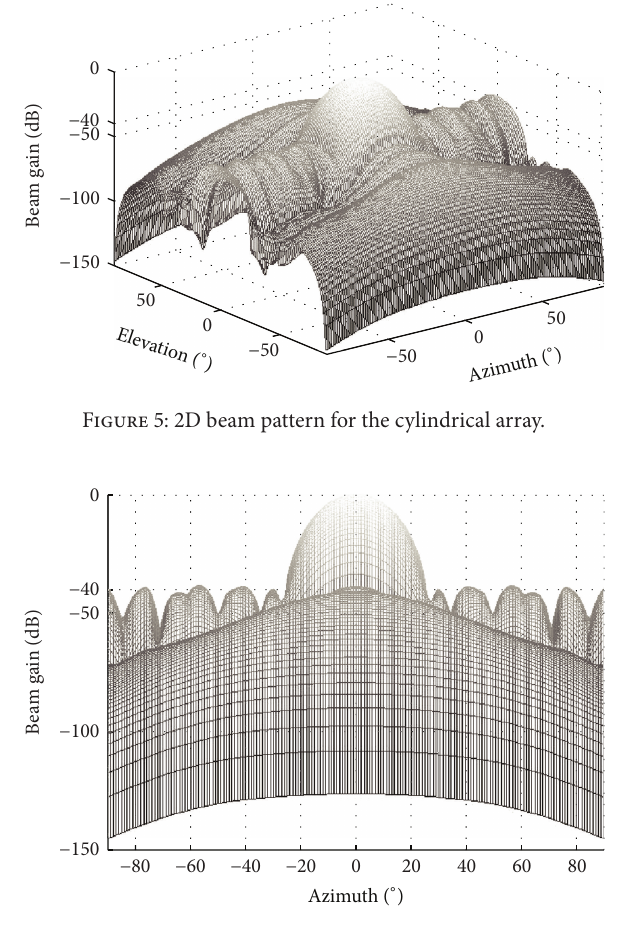
Figure 6: Beam pattern projection in the azimuth direction.